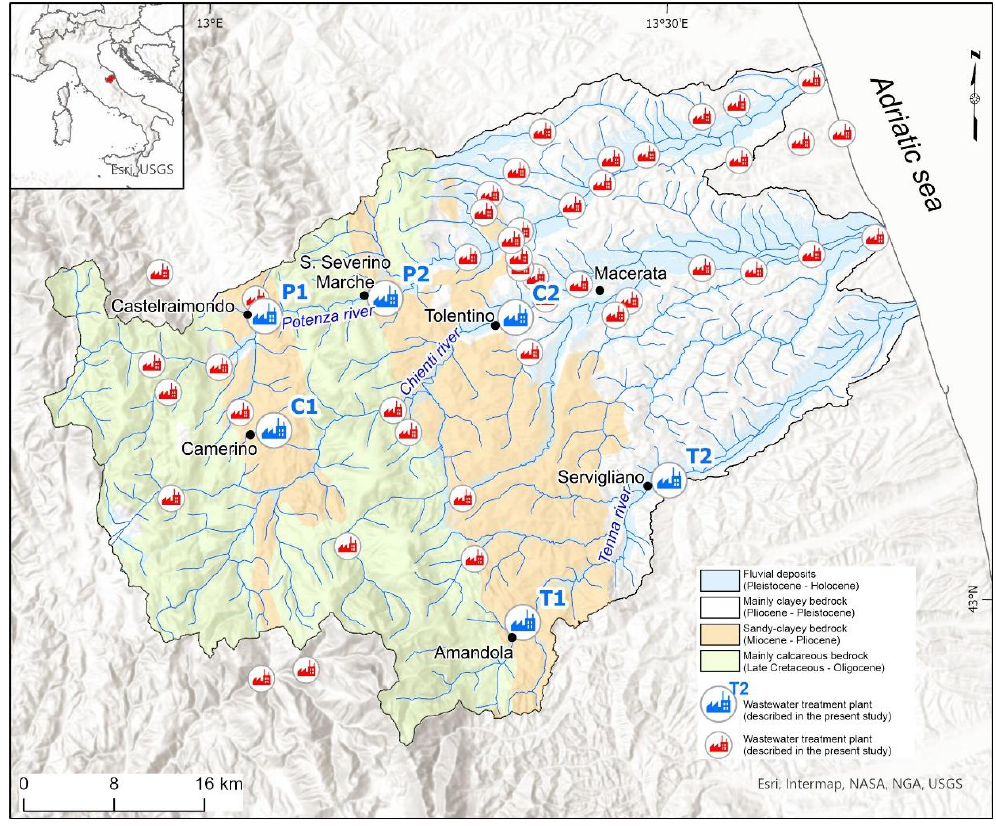
Figure 1. Schematic geological map of the study sector with the location of the main wastewater treatment plants (in blue those considered in the present study). P1: Castelraimondo; P2: S. Severino Marche; C1: Camerino; C2: Tolentino; T1: Amandola; T2: Servigliano.